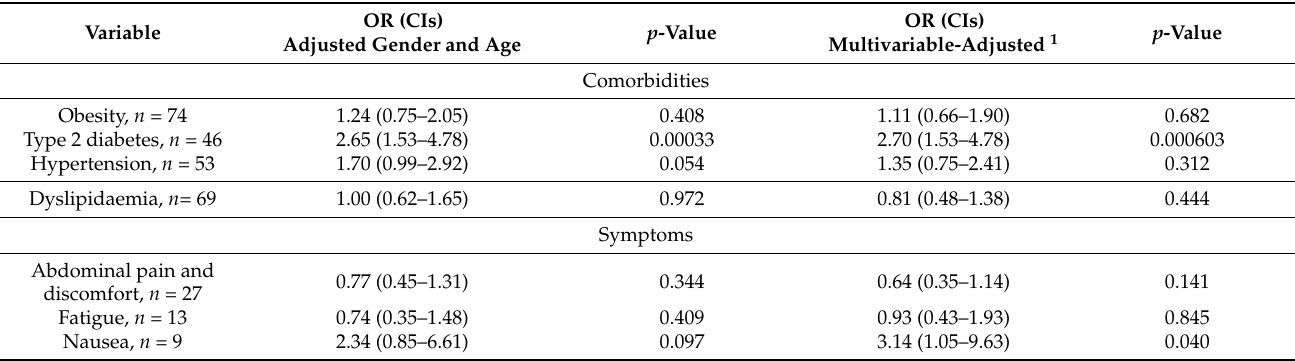
Table 3. Univariable logistic regression analyses (adjusted for age and gender) of possible predictors of NASH with significant fibrosis in 110 patients who underwent a liver biopsy. The table shows the odds ratios (OR) with 95% confidence intervals (CIs) and p